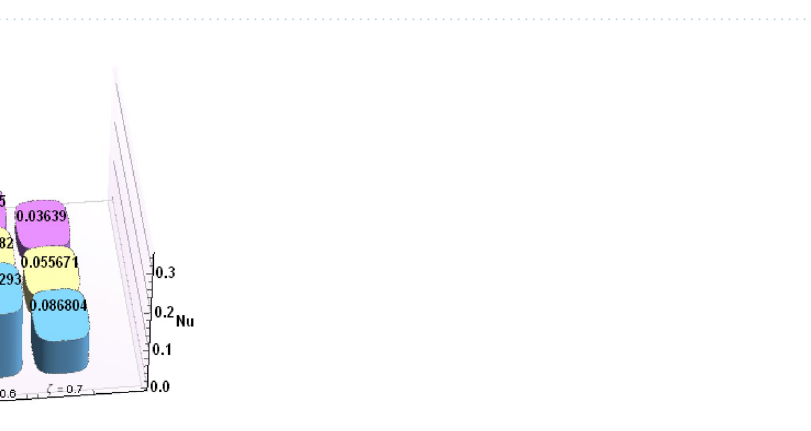
Figure 9. Bar chart representation of Skin friction coefficient and Nusselt number for different parameters using Mathematica 10 software available at (https:// softa sm. com/ wolfr am- mathe matica- 10-4- full- crack/). Nu versus θ e .